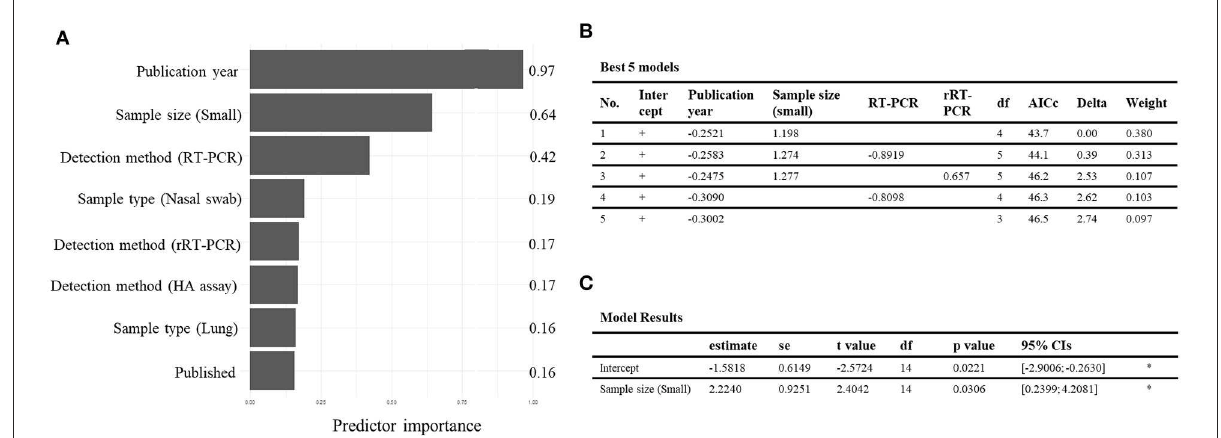
FIGURE4 Results of meta-regression analysis of the prevalence and the seroprevalence of swine influenza A virus (swIAV) in domestic pigs. (A) Model-averaged predictor importance plot for multiple meta-regression model of the swIAV prevalence data. (B) The best five multiple meta-regression models with the lowest corrected Akaike’s information criterion (AICc) for the swIAV prevalence outcome. (C) Meta-regression model with sample size for the swIAV seroprevalence